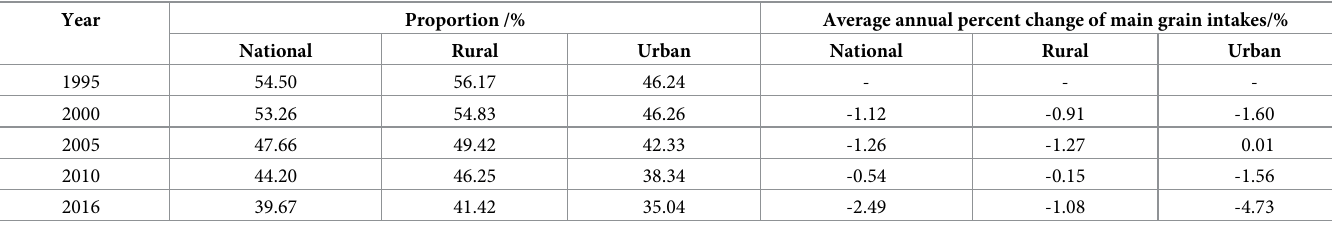
Table 2. The proportion and variation of main grain intakes in total food